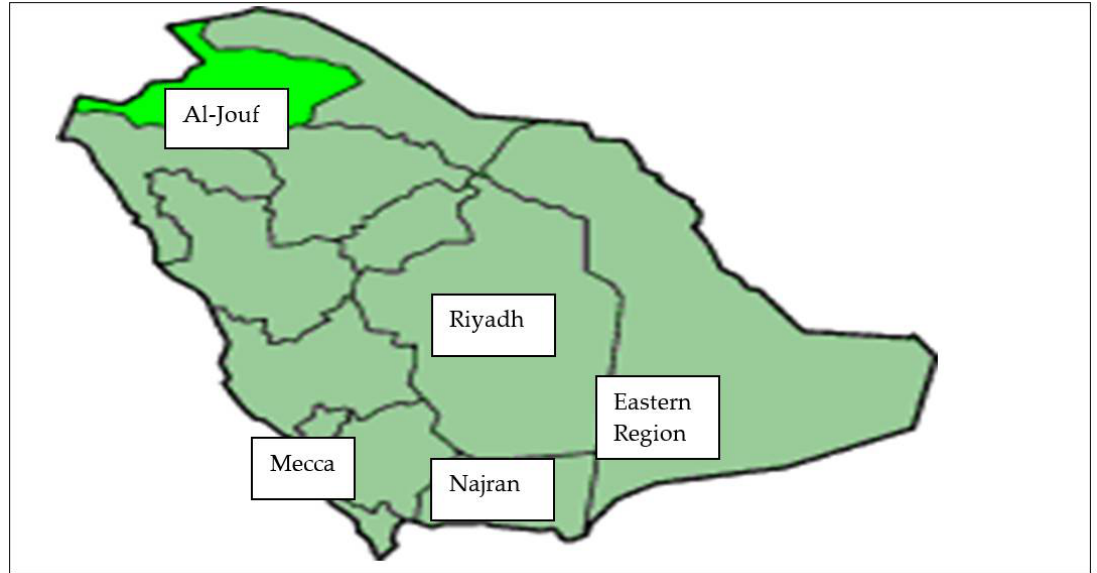
Figure 1. The map shows the five regions of this study. Central Region [Al Riyadh]; Eastern Region [Dammam]; Western Region [Mekka]; Southern Region [Najran]; and Northern Region [Al Jouf].